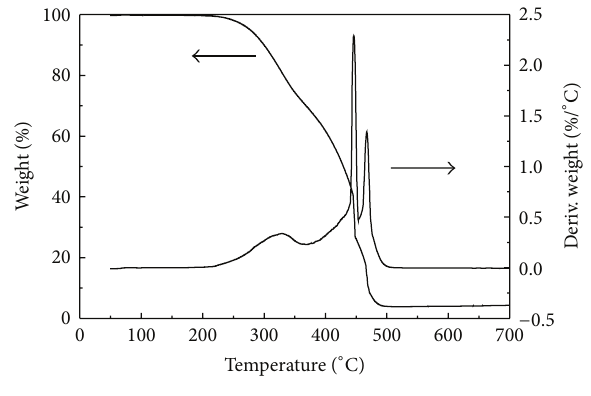
Figure 4: TG analysis of S4.